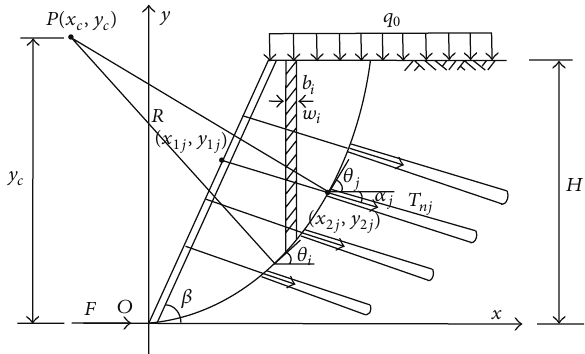
Figure 2: Stability analysis of grillage supporting structure with prestressed